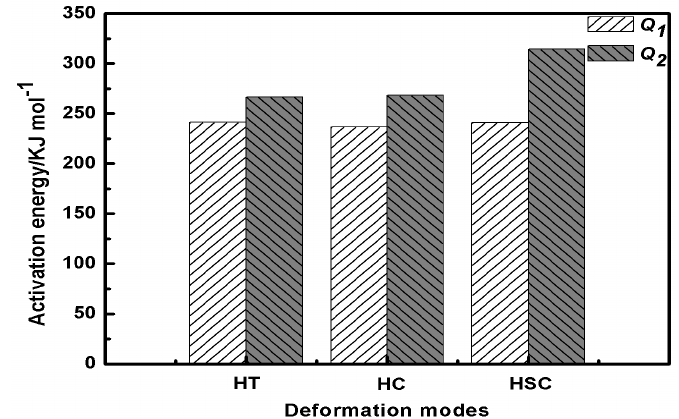
Figure 3. Comparison between the average values of the activation energy Q 1 and Q 2 for the three deformation modes.